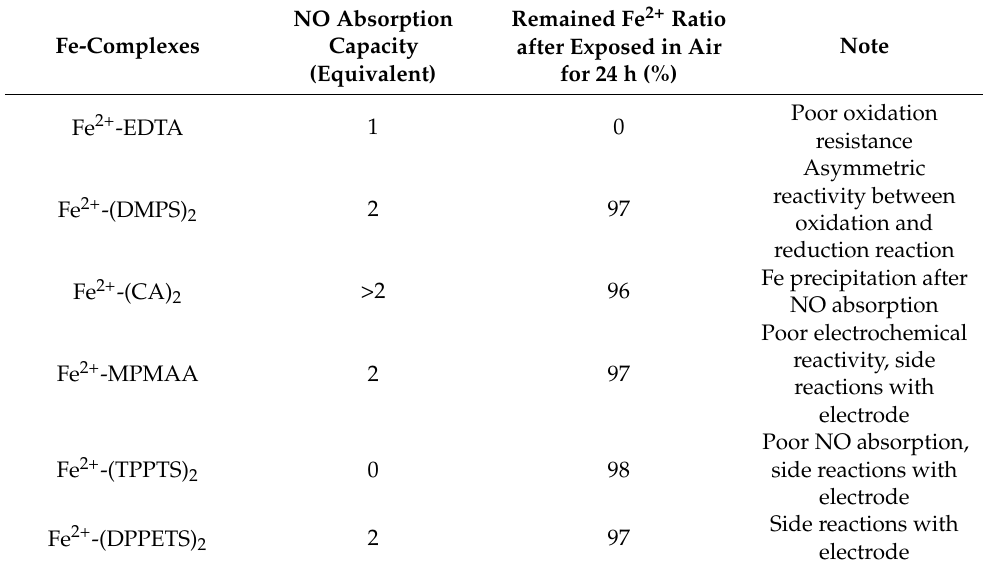
Table 1. NO absorption capacity of Fe-complexes and their oxidation resistance to air.